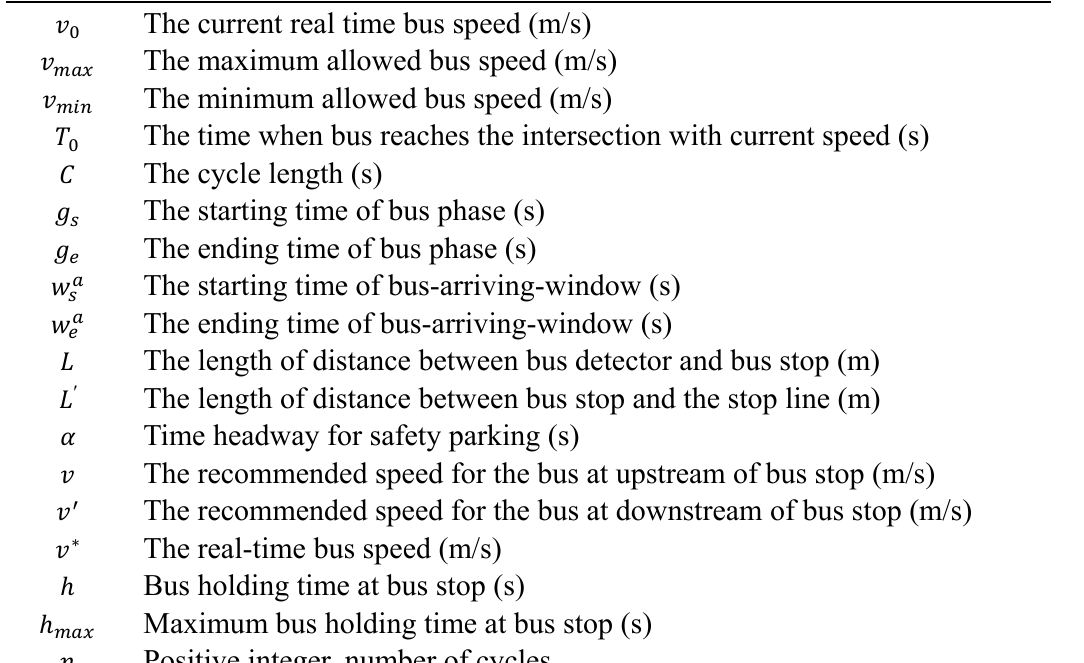
Table 1. Notations and